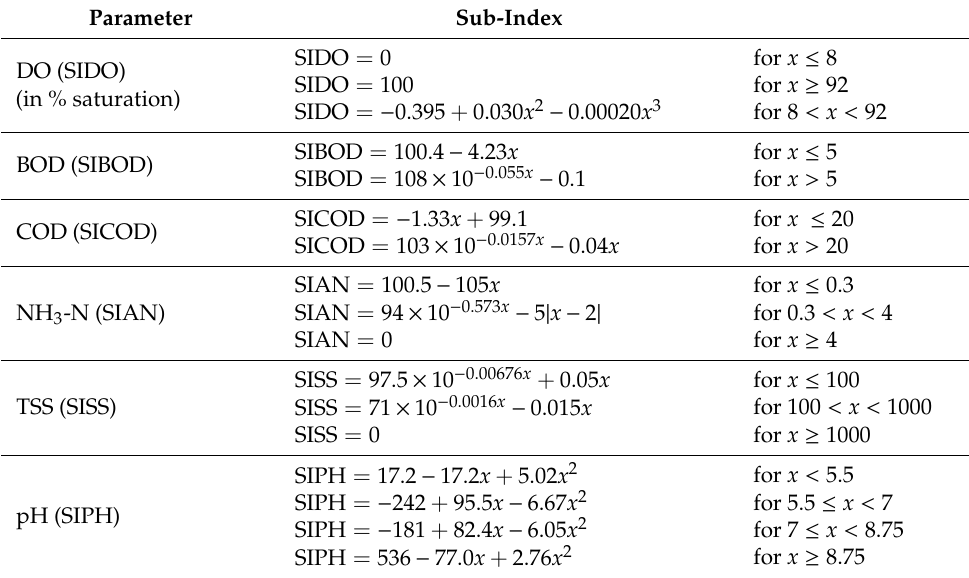
Table 3. Best fit equations for sub-index